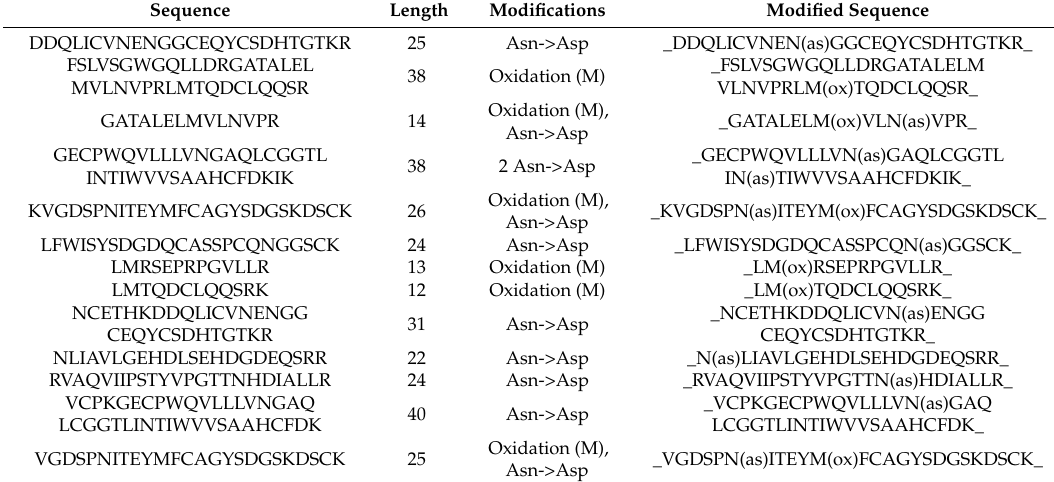
Table 1. Comparison of partial post-translational modification type and modified peptides found in NovoSeven ® and AryoSeven™ after tryptic digestion revealed by nanoflow liquid chromatography electrospray ionization tandem mass spectrometry (nLC-ESI–MS/MS; processed with